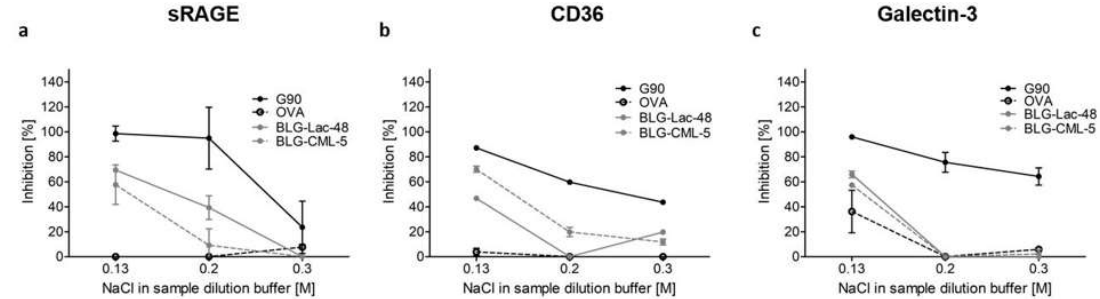
Figure 6. Inhibition ELISA for binding of ( a ) sRAGE, ( b ) CD36, and ( c ) galectin-3 to β-lactoglobulin (BLG), chemically modified BLG with N ɛ -carboxymethyl lysine (BLG-CML-5), BLG dry heated in the presence of lactose (Lac) for 48 hours using different concentrations of sodium chloride (NaCl) in the sample dilution buffer. Protein concentrations were set to 100 µg/mL. Error bars represent standard deviation of technical replicates ( n = 3).